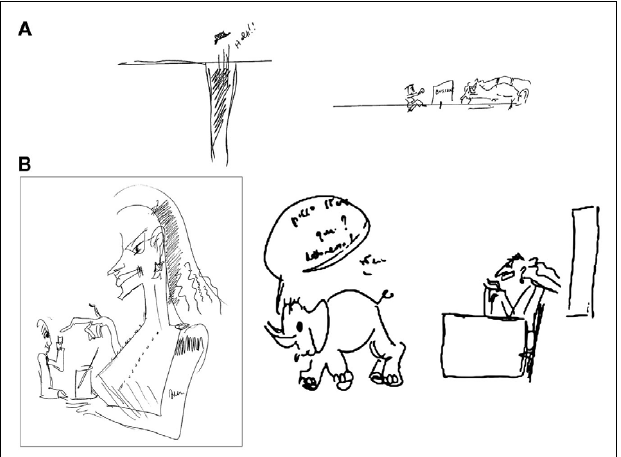
FIGURE 4 | Federico Fellini. (A) Two line bisections and Fellini’s additions. (B) Two drawings from memory.With permission from Cantagallo and Della Sala (1998) © 2011, ProLitteris,